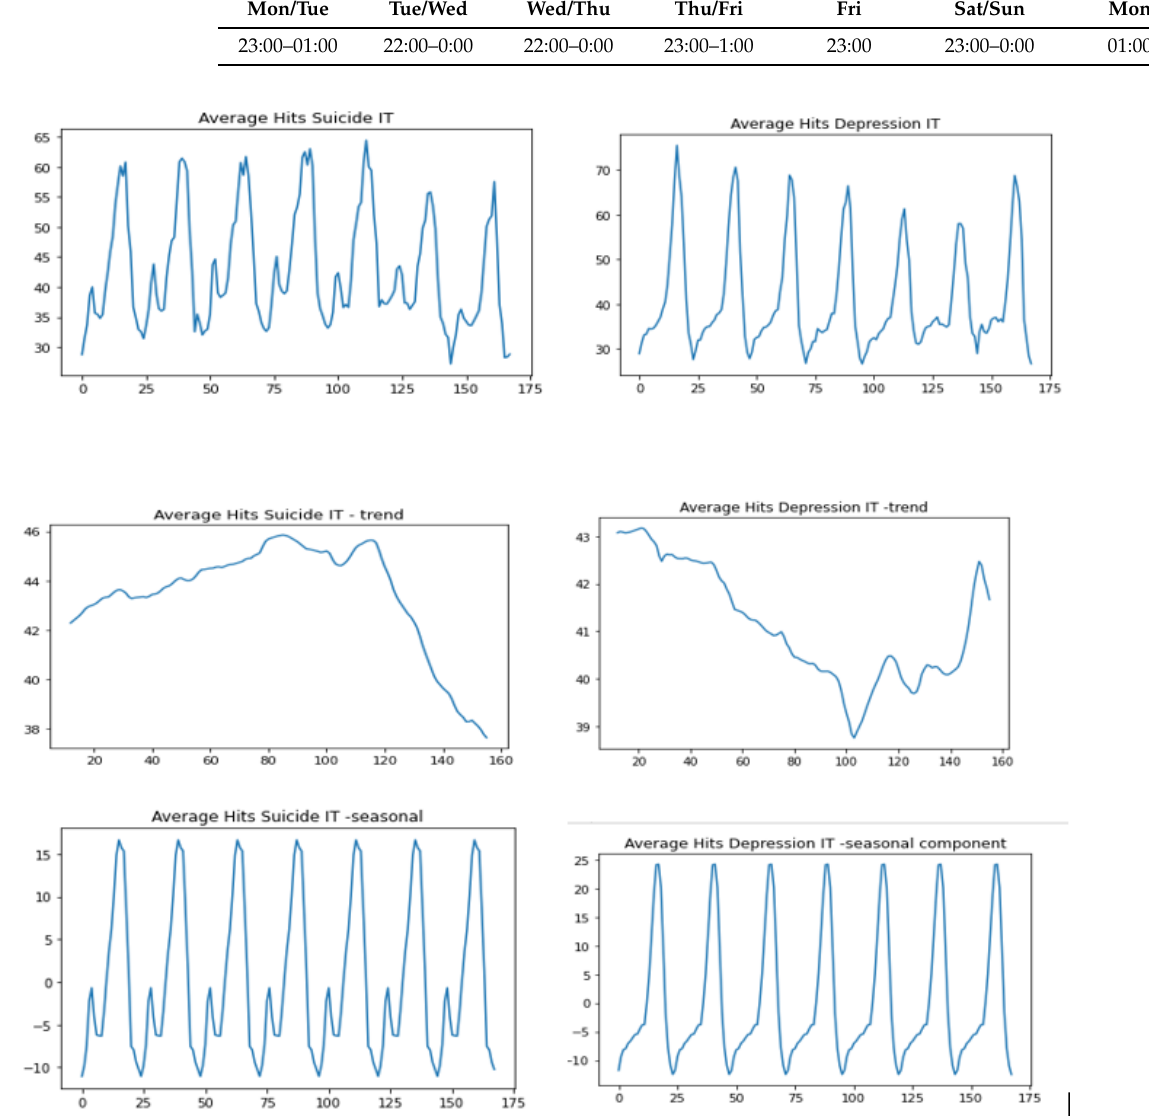
Figure 3. Hits “suicide” and “depression” for Italy–trend-seasonal